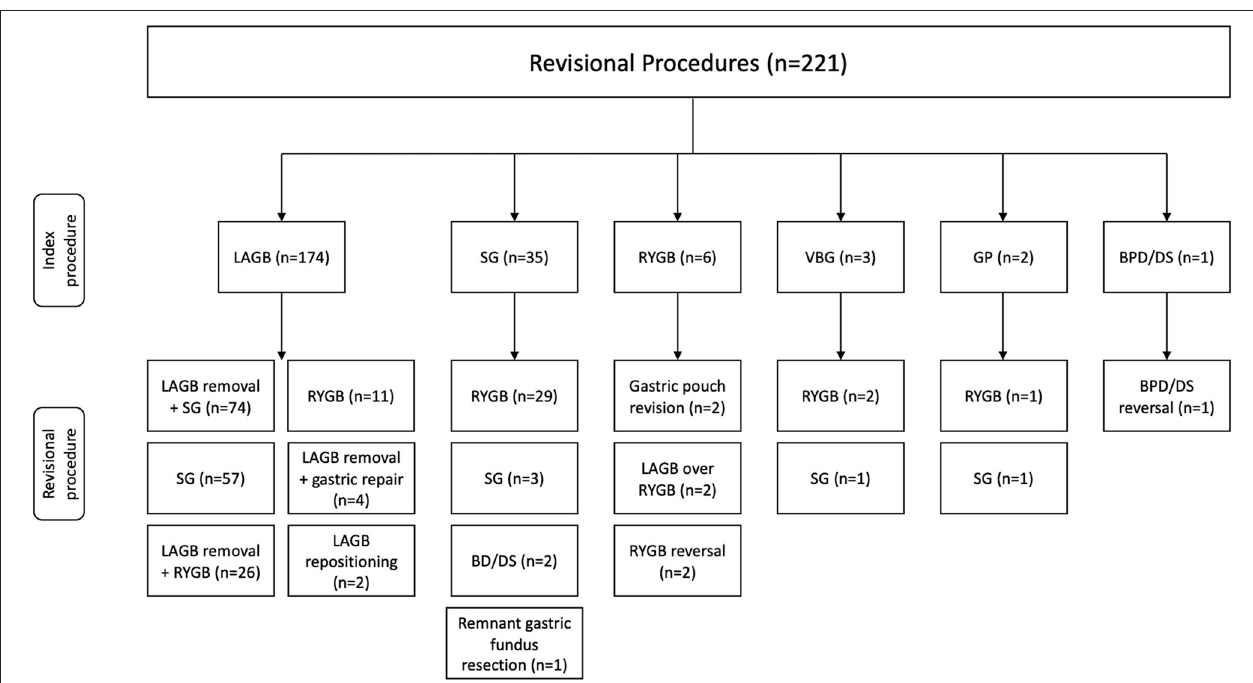
FIGURE 1 | Index and revisional procedures. LAGB, laparoscopic adjustable gastric banding; SG, sleeve gastrectomy; RYGB, Roux-en-Y gastric bypass gastric banding; VBG, vertical banded gastroplasty; GP, gastric plication; BPD/DS, biliopancreatic diversion with duodenal